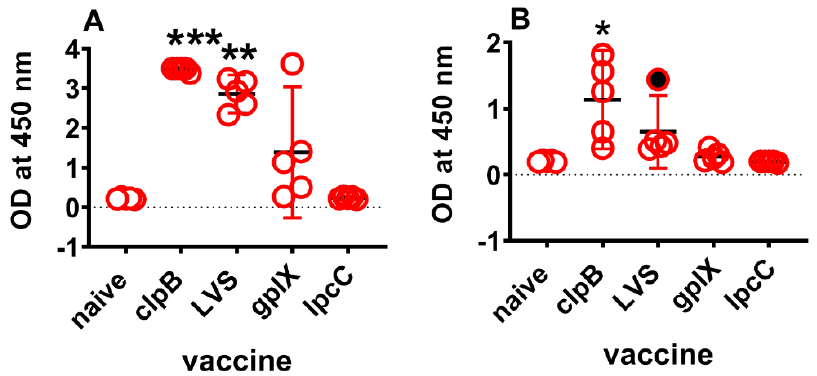
Figure 3. Serum Saa3 levels 4 days after vaccination. Blood was collected from mice ( n = 5/ group) 4 days after ID vaccination with one or other vaccine strain. Sera were diluted 2000-fold ( A ) or 10,000- fold ( B ) and tested for the presence of Saa3 according to the manufacturer’s instructions. Colour reaction was stopped after 15 minutes. Graphs were plotted as means (horizontal black dash) with 95% CI (red vertical lines). Dotted line is the limit of detection. Asterisks denote significantly higher levels than naïve sera by Kruskal Wallis analysis followed by Dunn’s test for multiple comparisons. *** (adjusted p = 0.0008), ** (adjusted p = 0.03), * (adjusted p = 0.01). Filled circle, outlier identified by ROUT analysis and excluded from calculations.